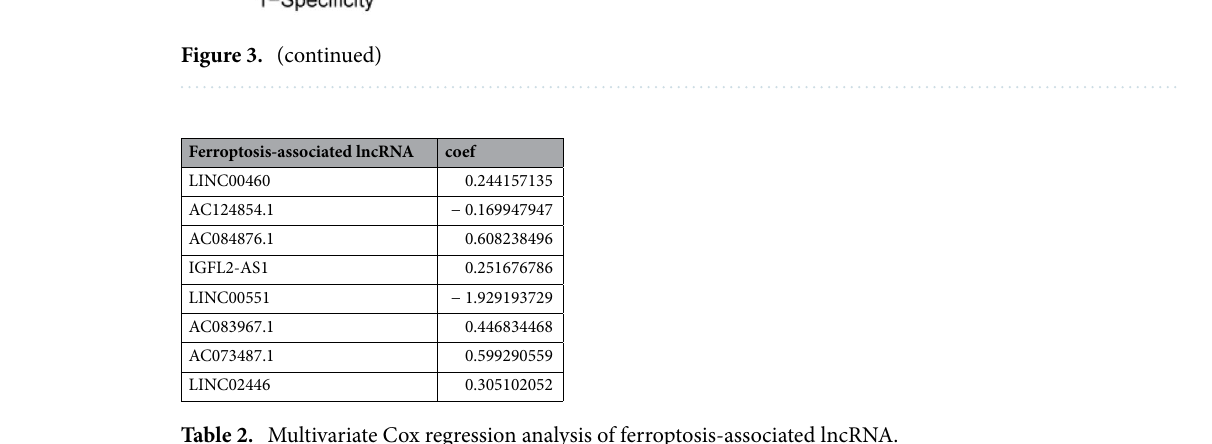
Table 2. Multivariate Cox regression analysis of ferroptosis-associated